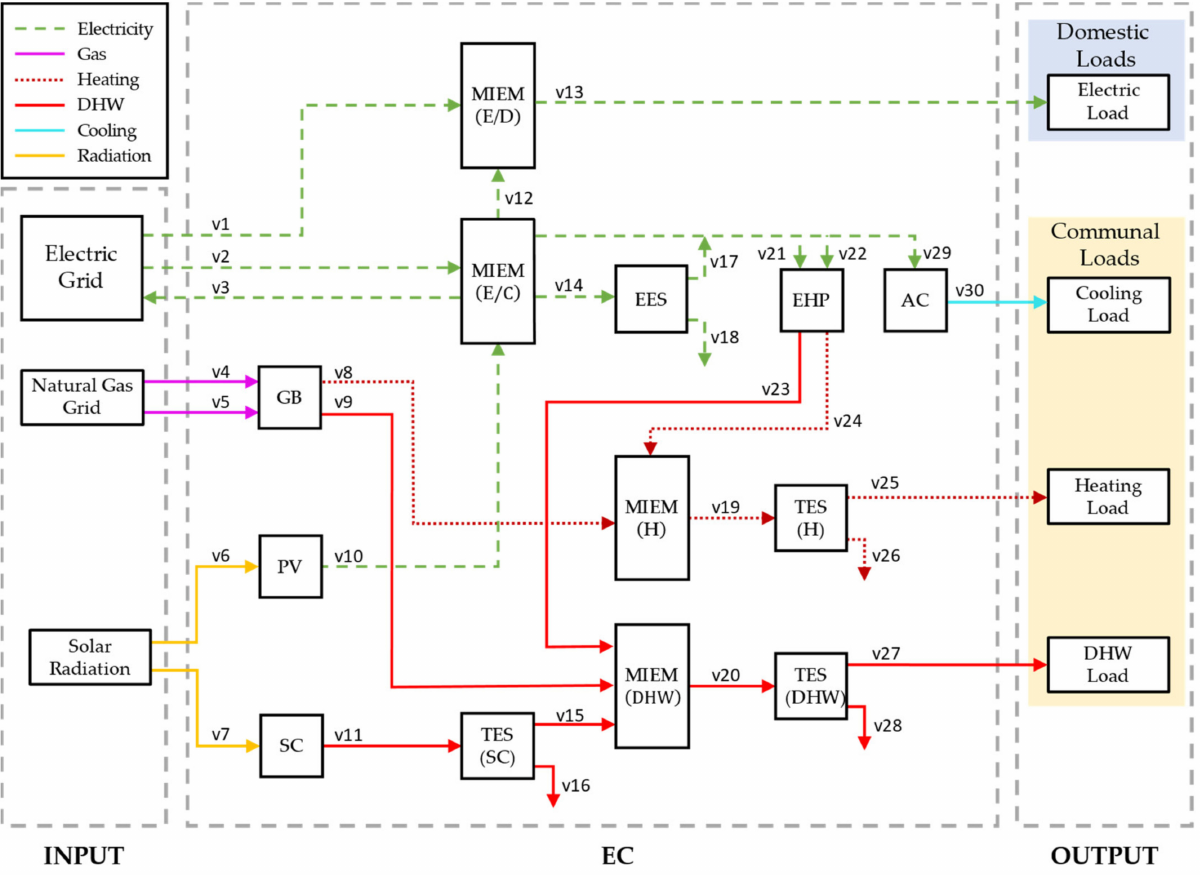
Figure 2. Initial topologic layout of the considered energy community (EC).